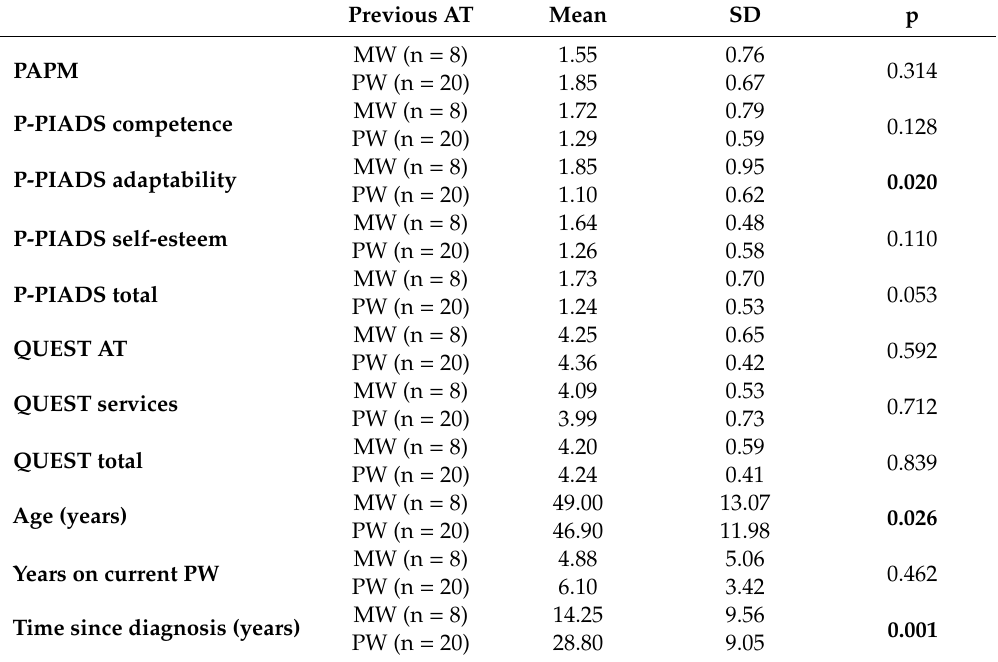
Table 6. Comparison of PAPM, P-PIADS and QUEST scores, age, number of years on the current PW and time since diagnosis, according to previous